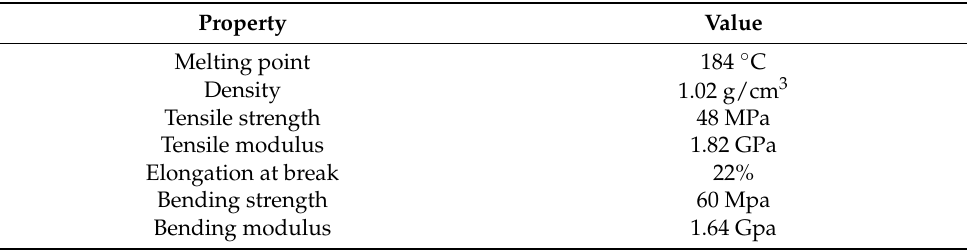
Table A1. The properties of PA12 materials.